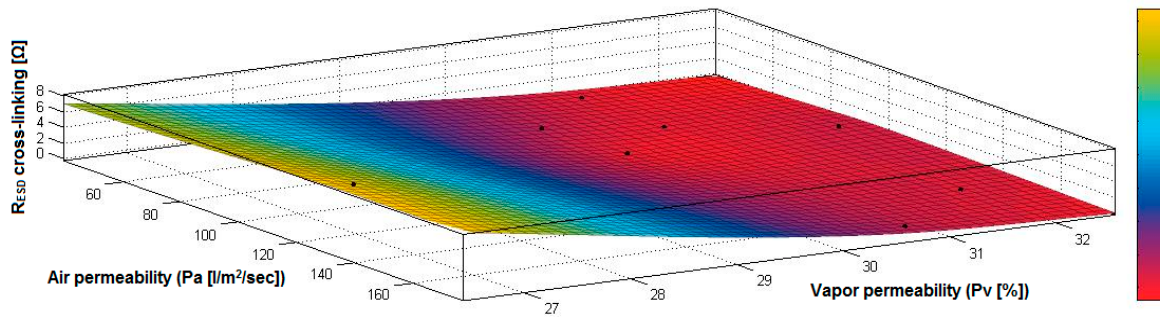
Figure 28. 3D representation R ESD after crosslinking = f(Pv, δ ) samples preliminarily treated in RF plasma O 2 using RF 1 generator and power 200 W.